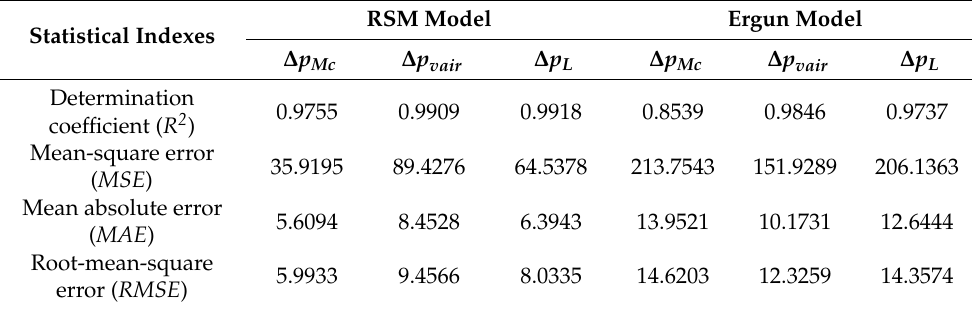
Table 7. The statistical results for the single factor